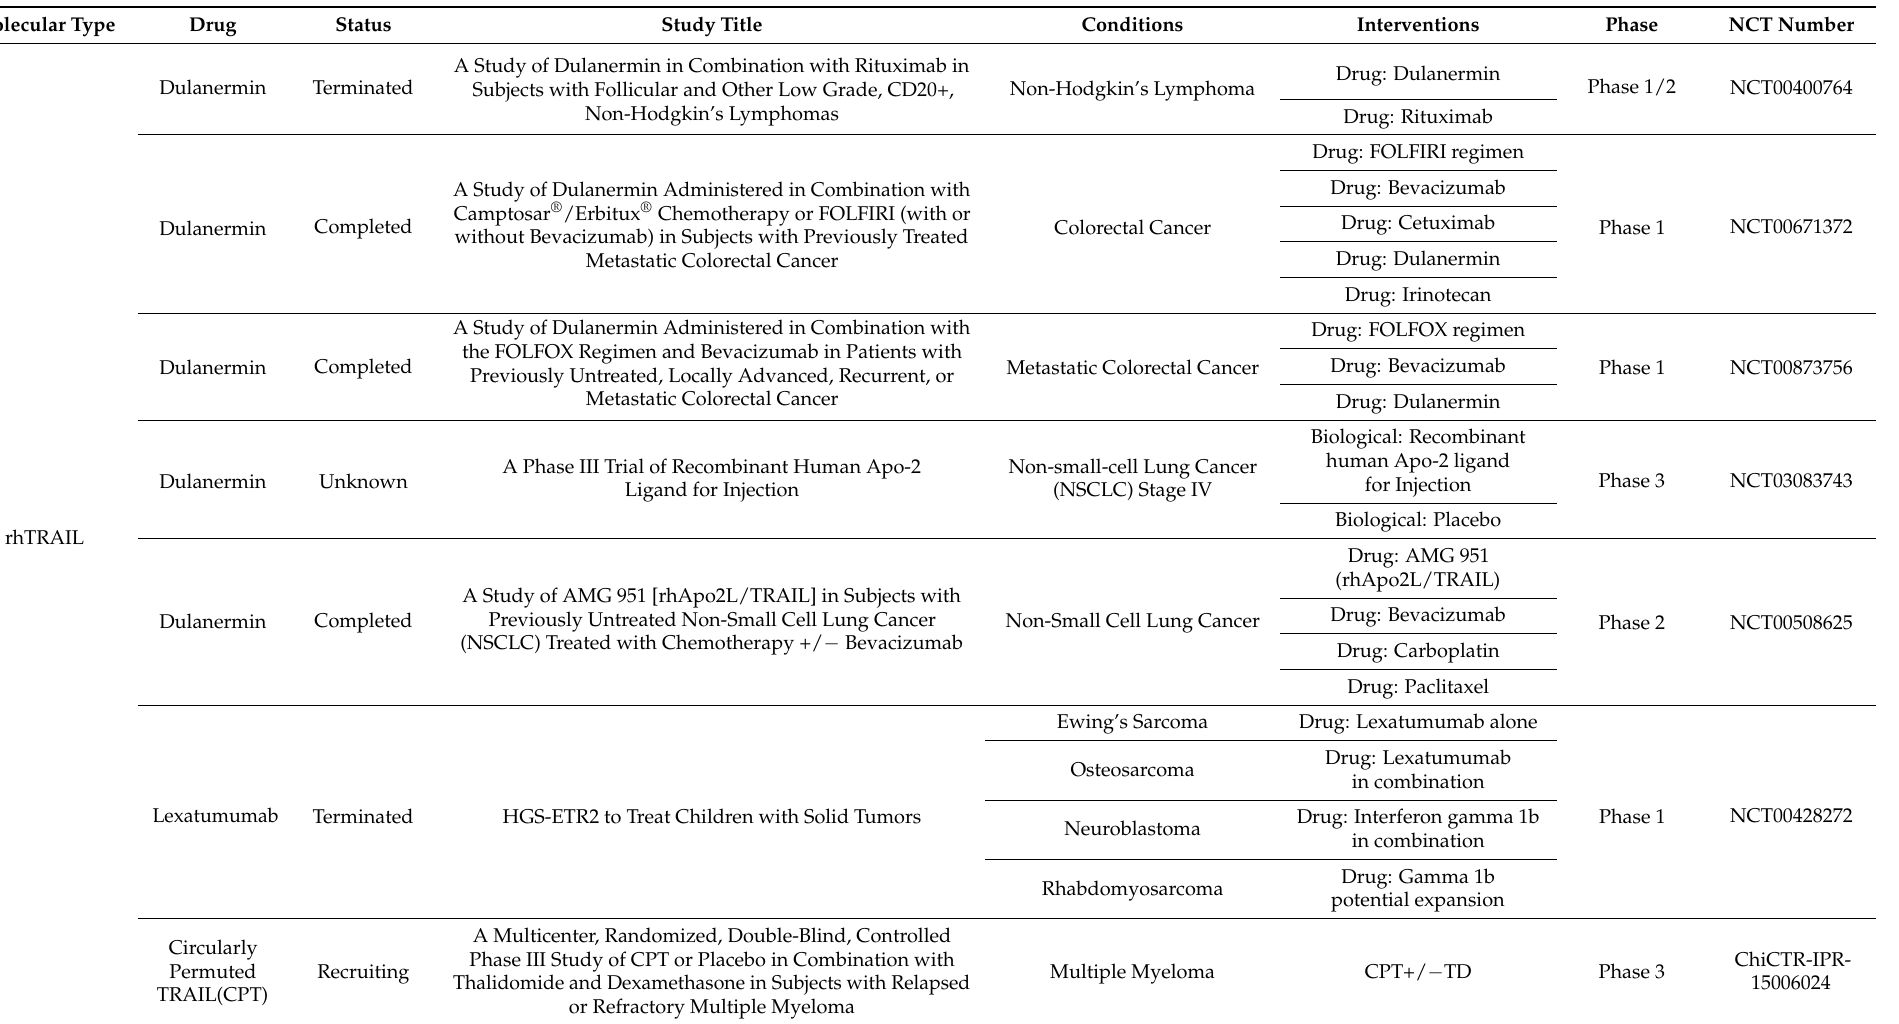
Table 1. Summary of clinical trial for TRAIL/DR Pathway targeting